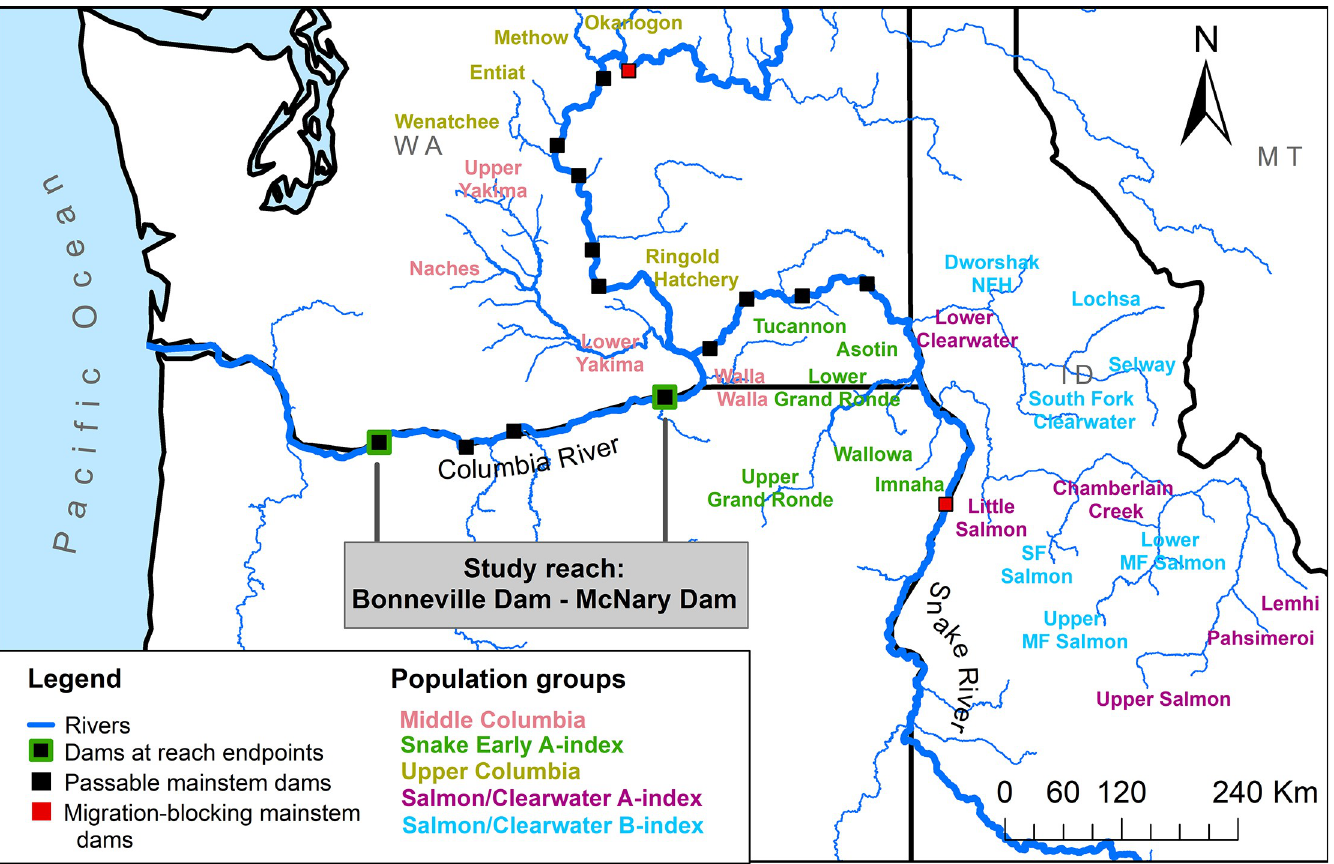
Fig 1. Study area map. Map of study area showing the study reach and the location of each population within each population group. Salmon/Clearwater A- and B- index populations are labeled by whichever group represented the majority of tags within the tributary (some hatchery programs release fish with genetics from one life- history strategy into populations that are primarily composed of the other). While Pahsimeroi River steelhead are generally considered A-index, our dataset contained a significant number of tags from hatchery-raised B-index stock that are released in the basin.